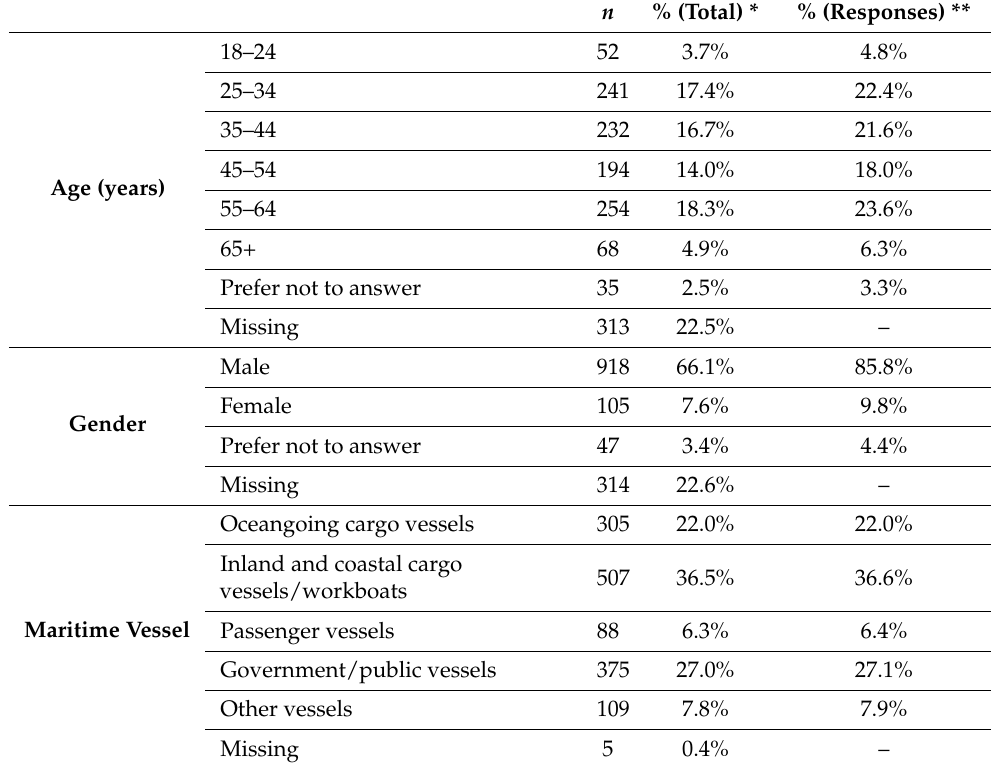
Table 1. Characteristics of